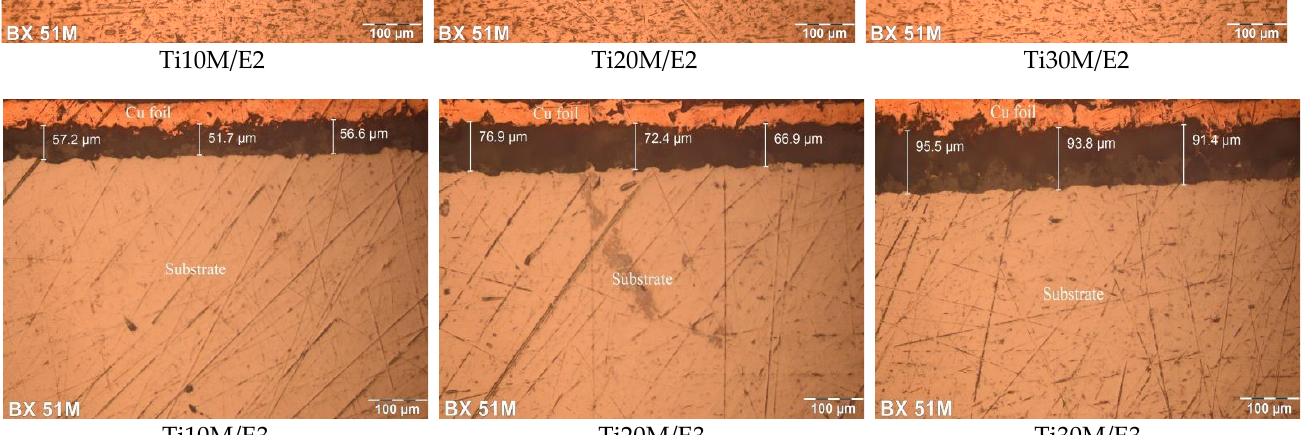
Figure 4. Cross-sectional metallographic images of the PEO layers for the three sets of experiments. Table 2. Obtained thickness, microhardness and critical load values for the PEO layers after three sets of experiments.